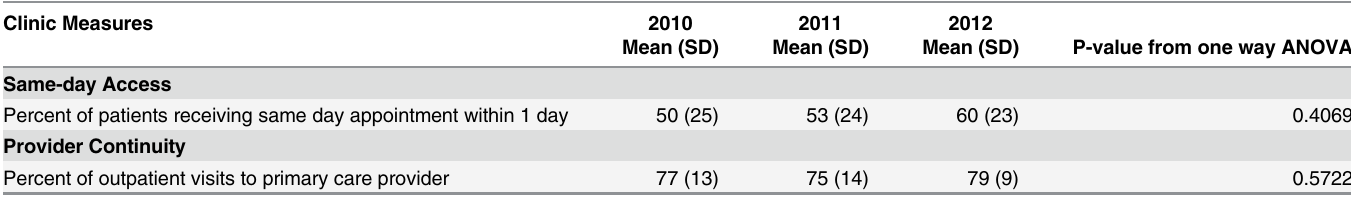
Table 2. Primary Care Clinic Access and Continuity by Year, N = 22.